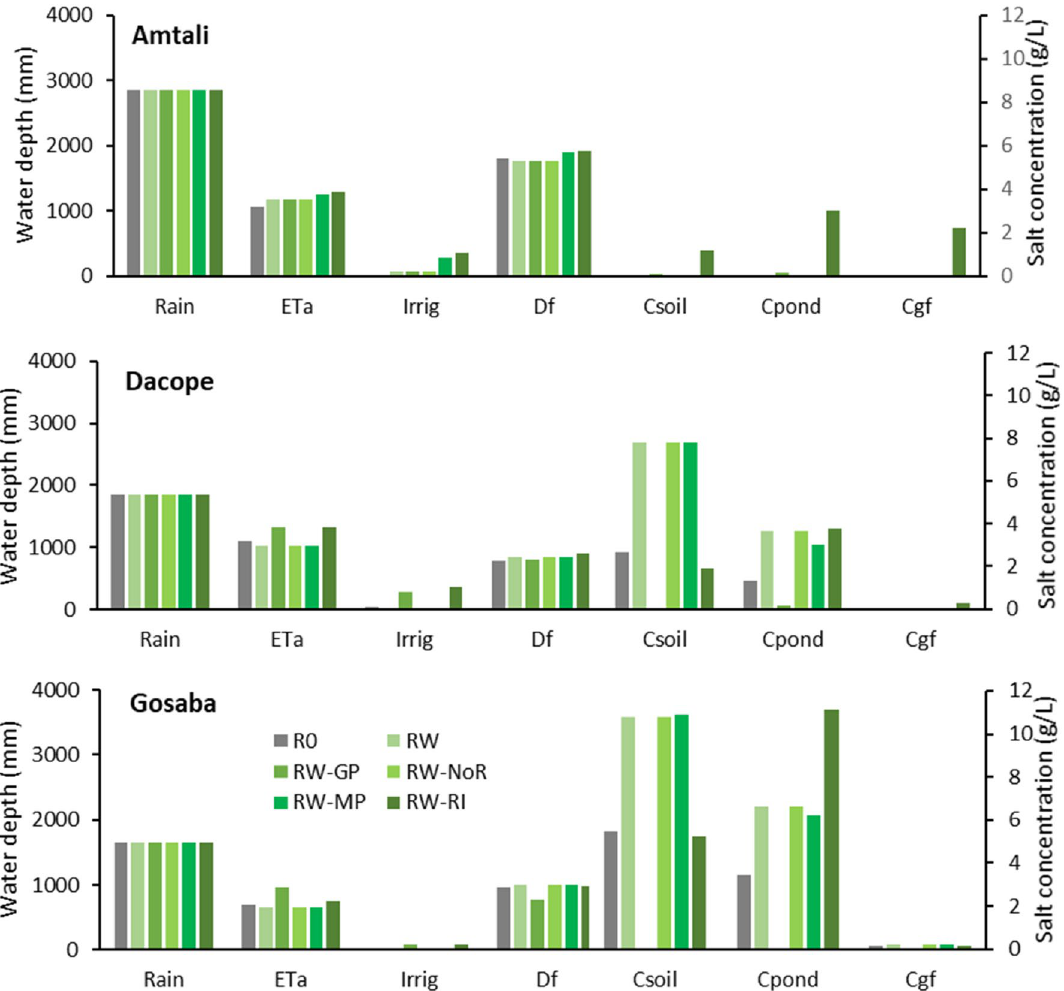
Figure 6. Comparison of water and salt balance for 5 land management scenarios for the Amtali (top) and Dacope (middle) polders and Gosaba Island (bottom) (base case scenarios i and scenarios ii to vi). Each group of columns shows the average annual water depth (left axis) and salt concentration (right axis). The average annual water depths are rain, actual evapotranspiration (ETa), applied irrigation (Irrig), and surface drainage from the fields which is equivalent to runoff from the soil to the canals and ponds (Df). The salt concentrations are concentration in the soil water (Csoil), in the pond water (Cpond) and in the fresh shallow groundwater